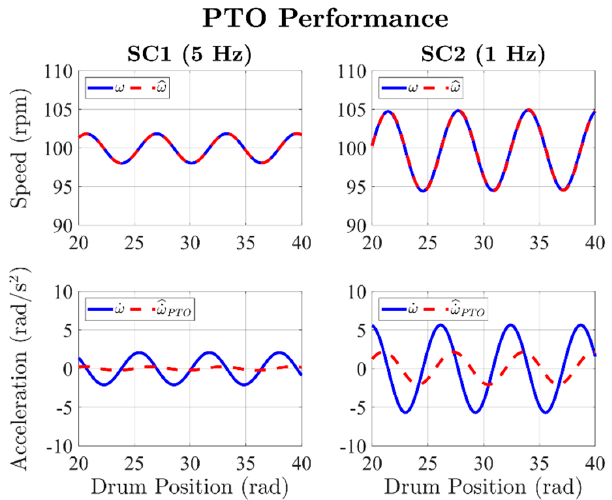
Figure 14. Speed- and acceleration-tracking performance of the PTO.